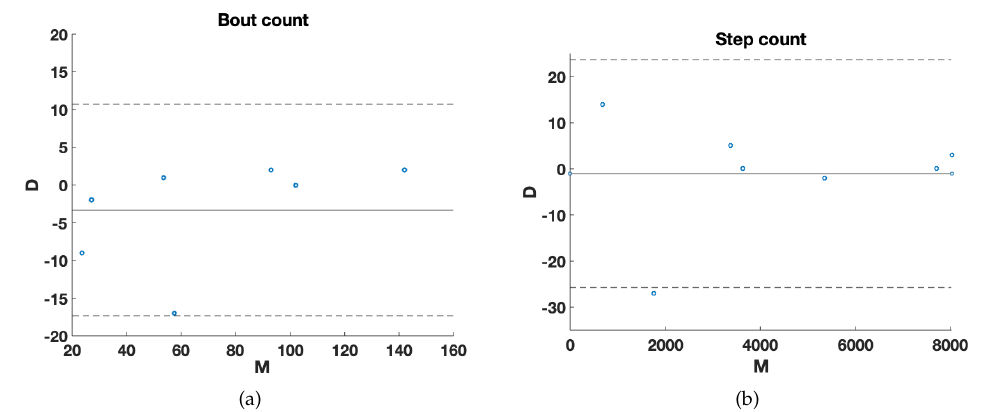
Figure 7. Bland–Altman plots for: ( a ) bout count; ( b ) step count. The difference (D) between the algorithm and the video recording as the y–value, and the mean (M) between the two measurements as the x–value. While solid line in each plot represents the mean count difference between the algorithm and video, dashed lines represent 95% limits of